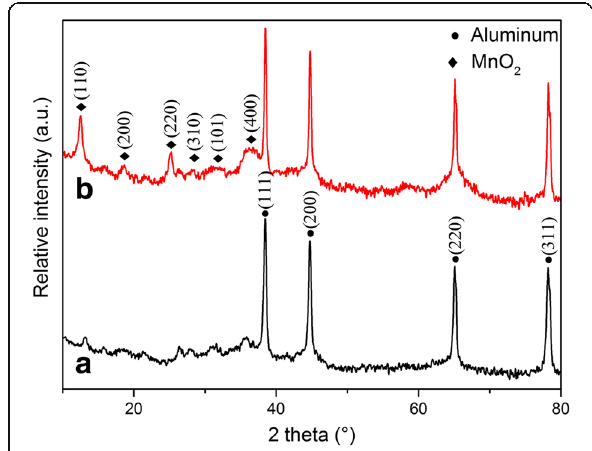
Fig. 1 XRD analysis for Al/MnO 2 composite pigments with ( a ) S2 and ( b )